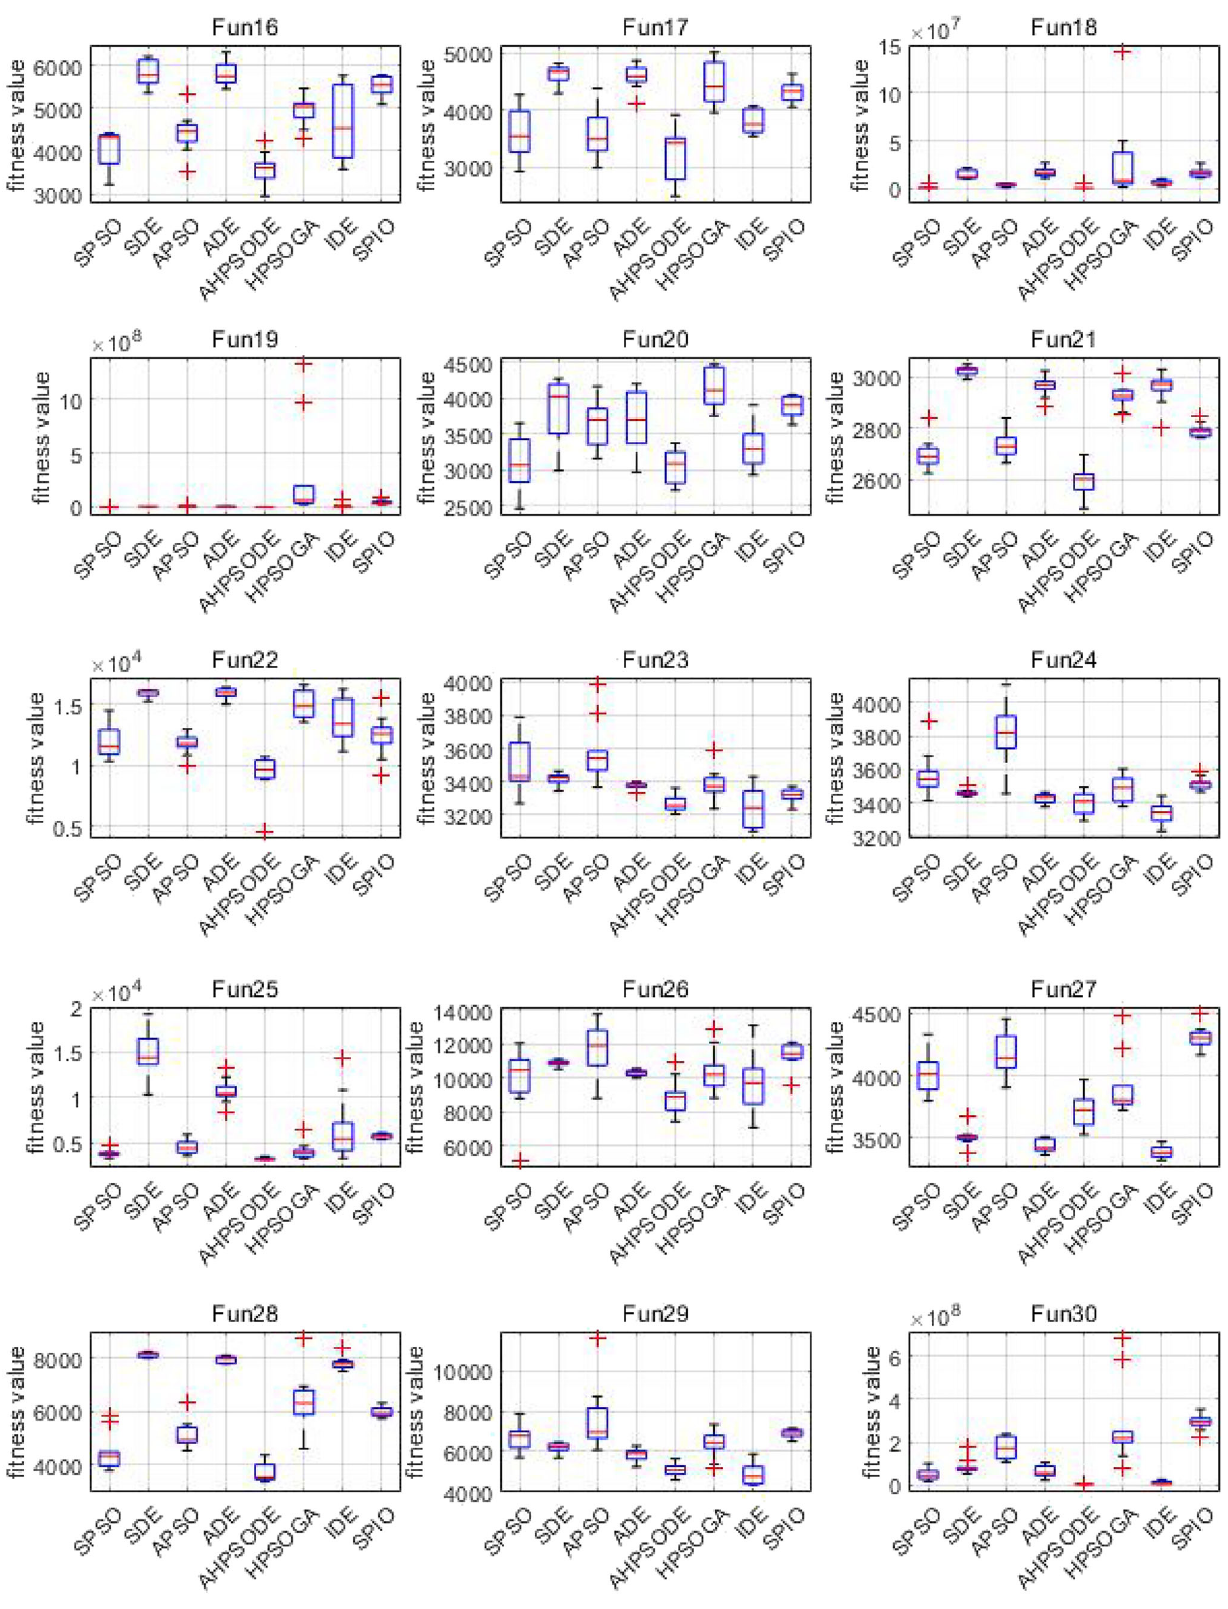
Fig. 22 Box plot of different algorithms on CEC 2017 at 50-D (Fun